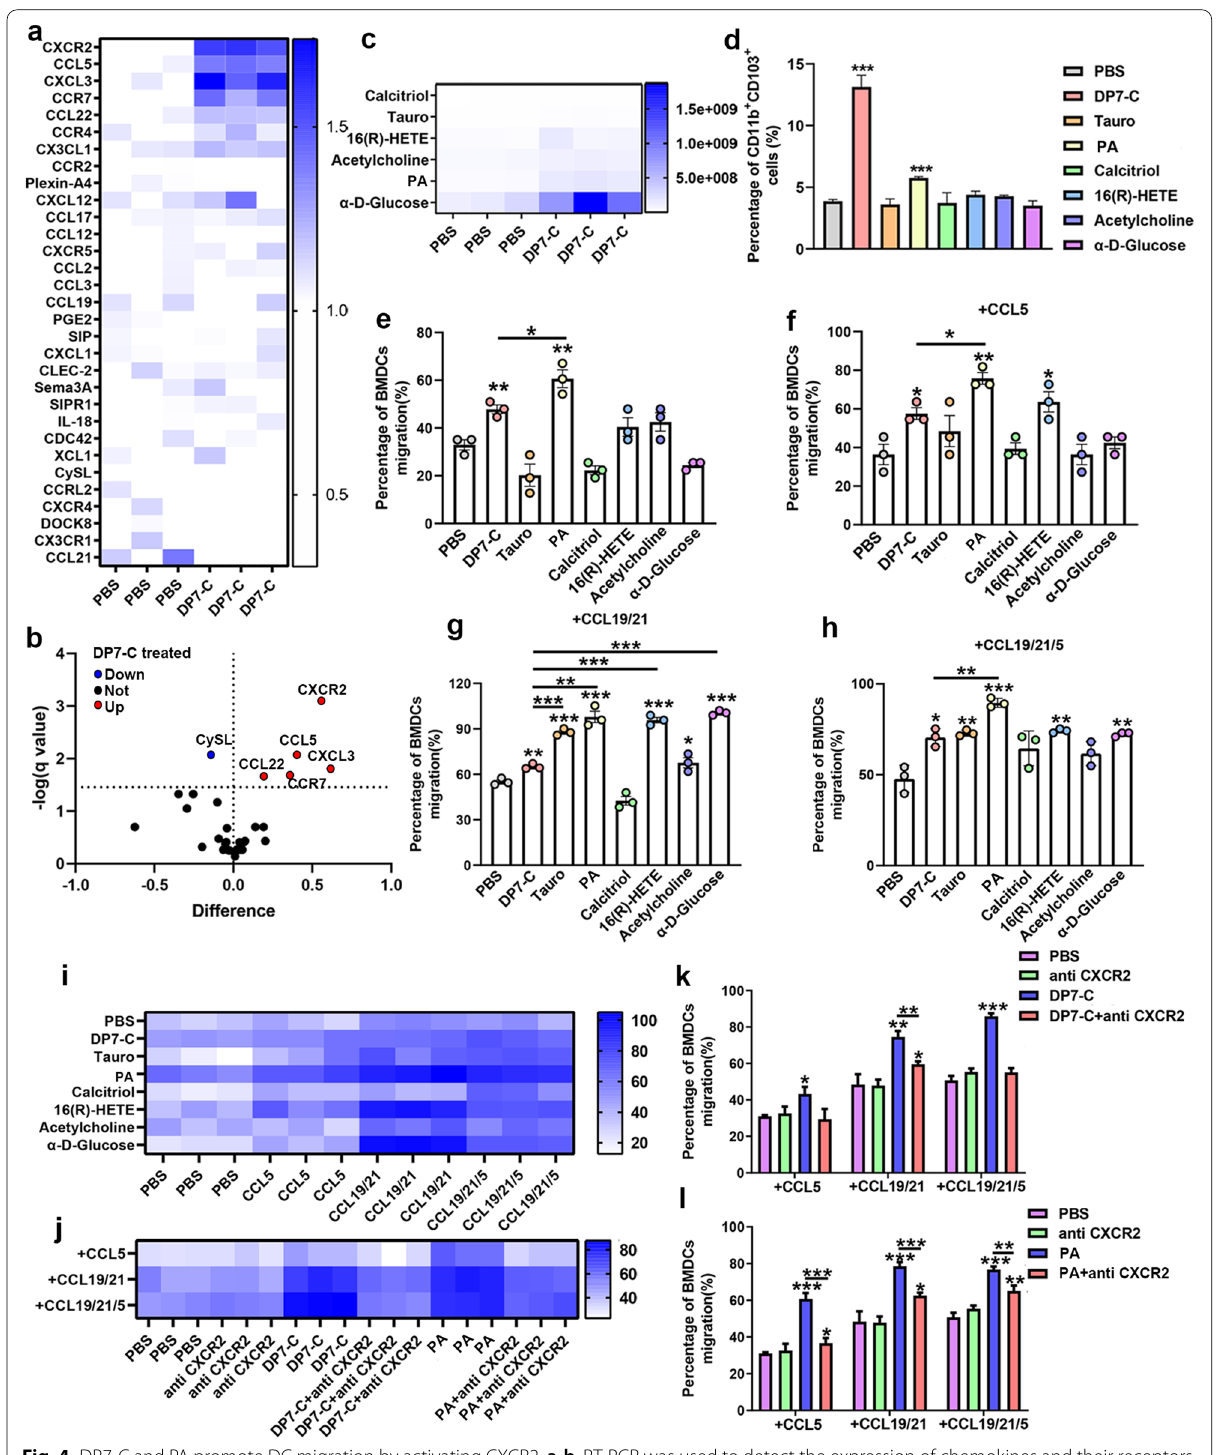
Fig. 4 DP7-C and PA promote DC migration by activating CXCR2. a‑b . RT-PCR was used to detect the expression of chemokines and their receptors in DCs treated with DP7-C. c . Metabolomics sequencing detected that DP7-C increased the content of migration-related metabolites in DCs. d . Flow cytometry was performed to detect the percentage of CD103 + DCs among all DCs after metabolite treatment. e‑i . Transwell assays were used to detect the efficiency of DC migration in vitro after different treatments. j‑l . Pretreatment of DC with CXCR2 antibody inhibited DP7-C and PA-mediated DC migration in vitro. Significance was calculated using a one-way ANOVA with multiple comparisons tests (* p < 0.05, ** p < 0.01, *** p <